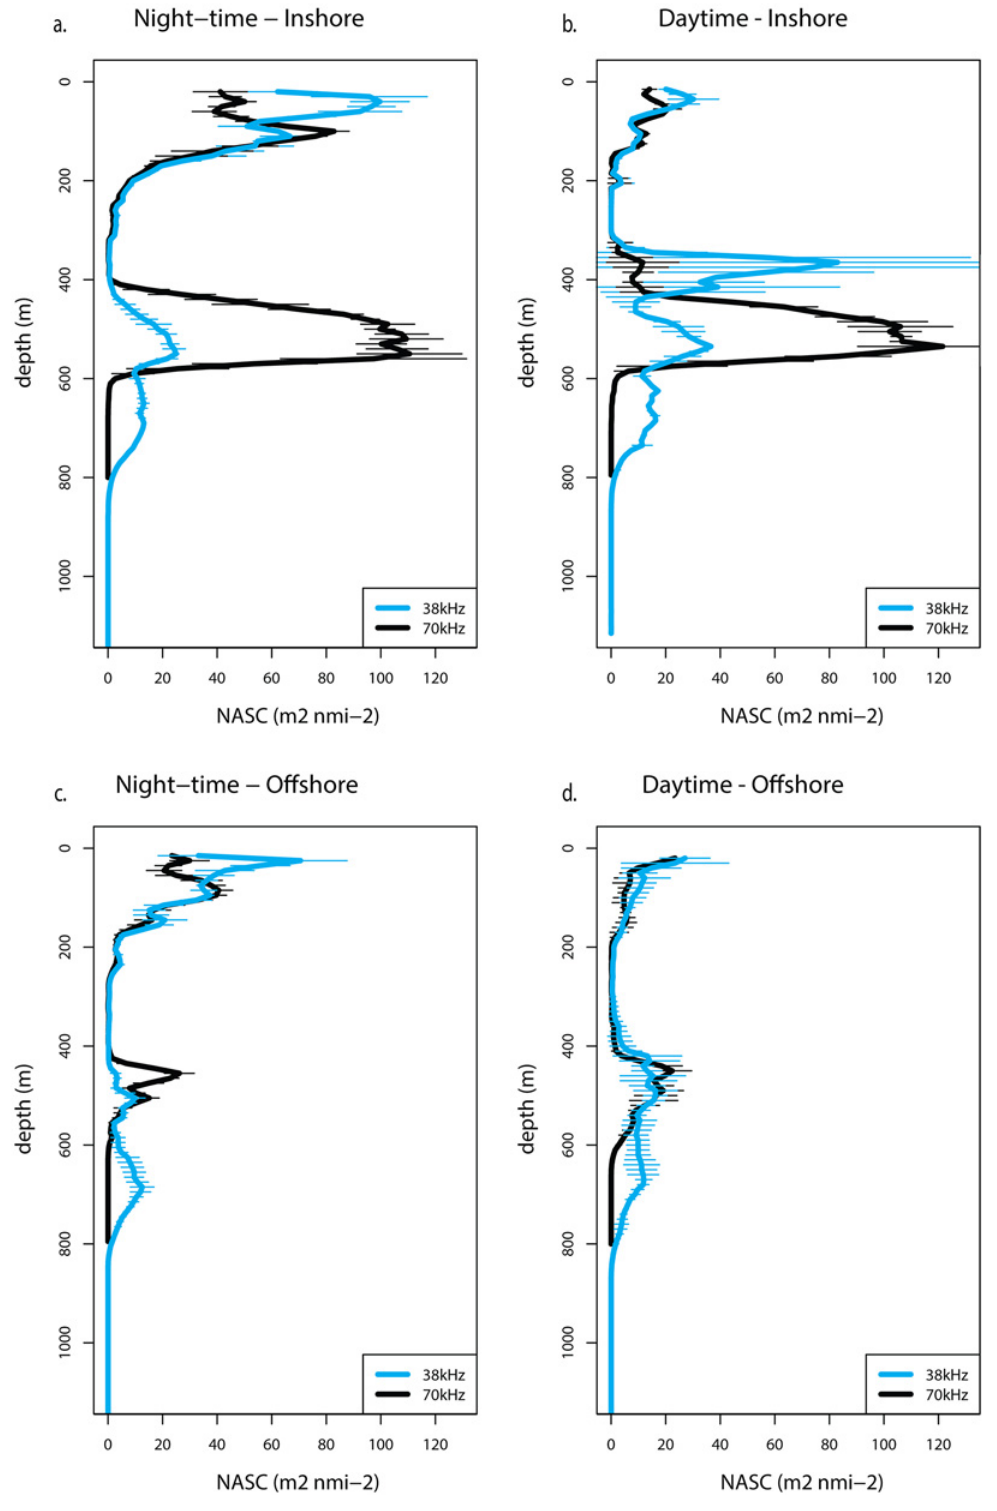
Fig 5. Depth profiles of NASC. Depth profiles of NASC from the 2011 cruise for the 38 kHz (blue lines) and 70 kHz (black lines) transducers at one inshore location (a-b) and one off-shore location (c-d) during the night-time (left) and the daytime (right). See Fig 4D for inshore and offshore locations.